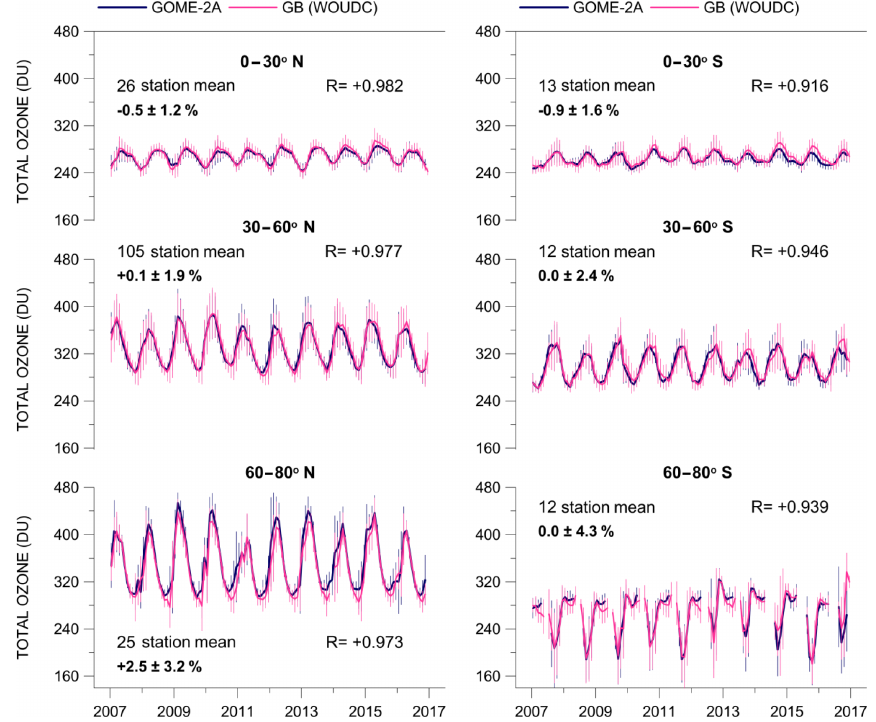
Figure 2. Same as in Fig. 1, but for GOME-2A and GB observations. R is the correlation coefficient between the two lines. Error bars show the standard deviation of each monthly mean. Mean differences ± σ are given as (GOME-2A – GROUND)/GROUND (%). Table 2. Statistics of the correlations shown in Figs. 1 and 2 between total ozone from (a) GOME-2A data and SBUV (v8.6) overpass data and (b) GOME-2A data and ground-based measurements.